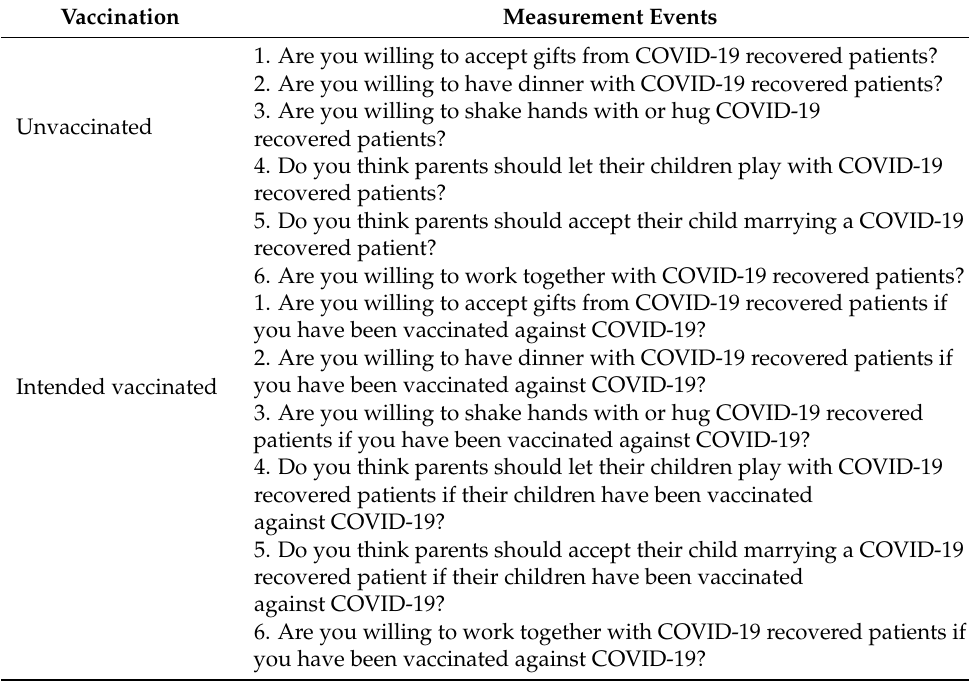
Table 1. Life events measures of discrimination against recovered COVID-19